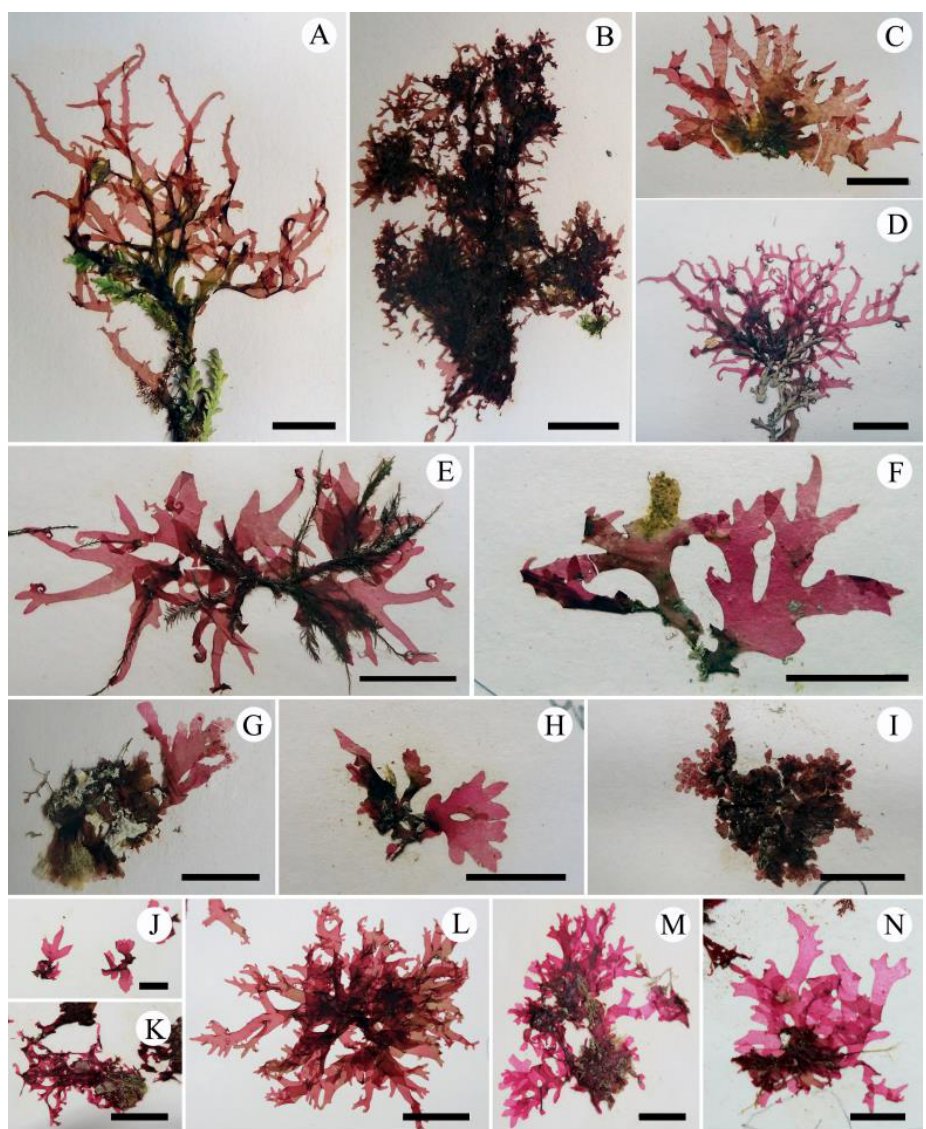
Figure 7. Specimens of ‘ Acrosorium ciliolatum’ from outside of the NW Pacific. ( A – C ) From Tasmania, Australia (( A ), JN15110800R5; ( B ), JN1309080014; ( C ), JN1511080067). ( D ) From New Zealand (JN1309080014). ( E – I ) From Spain (( E ), JN1404280001; ( F ), JN1404300010; ( G ), JN1404280053; ( H ), JN1404280046; ( I ), 1405010034). ( J – N ) from California, USA (( J ), UC1934340; ( K ), UC1965235; ( L ), UC1835679; ( M ), UC2034311; ( N ), UC2034278). Scale bars: ( A – J , M , N ), 1 cm; ( K – L ), 2 cm.